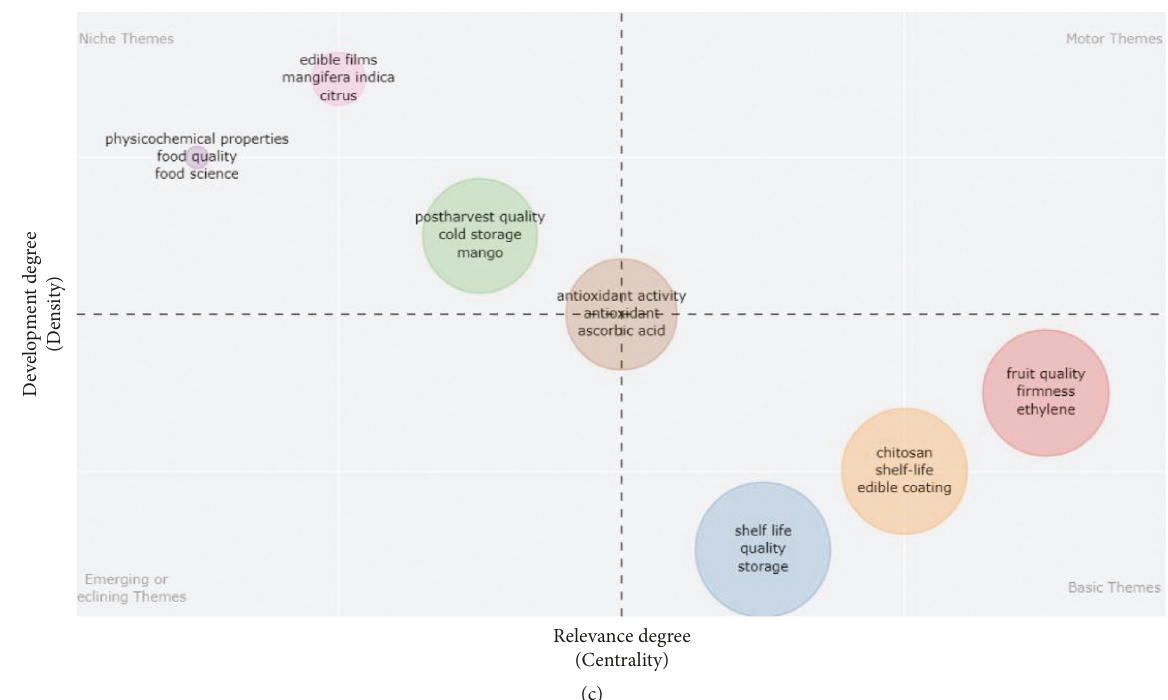
Figure 2: The strategic diagrams for shelf-life extension technology-related research from (a) 2000–2006, (b) 2007–2013, and (c)